Question: Express in one sentence what the figure is showing.
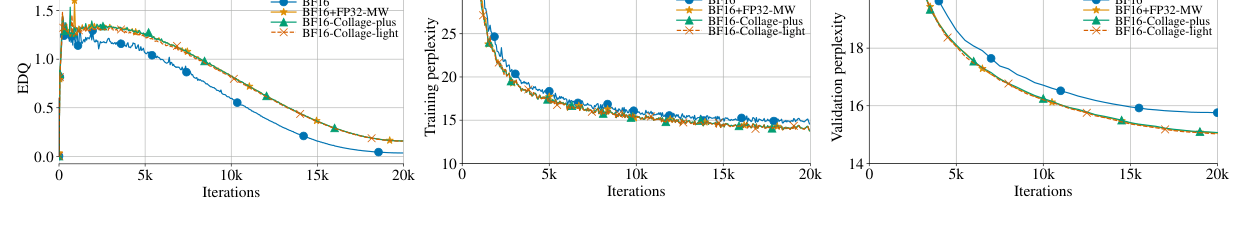
Answer: Pretrainnig progress for GPT 125M with settings described in Section 5.2 and global batch-size=1024, β2 = 0.99. Top-left: EDQ metric vs iterations, top-right: training perplexity vs iterations, and bottom: validation perplexity vs iterations for different precision strategy listed in Table 2. The proposed COLLAGE formations consistently match the FP32 master weights with much less memory footprint and faster training.